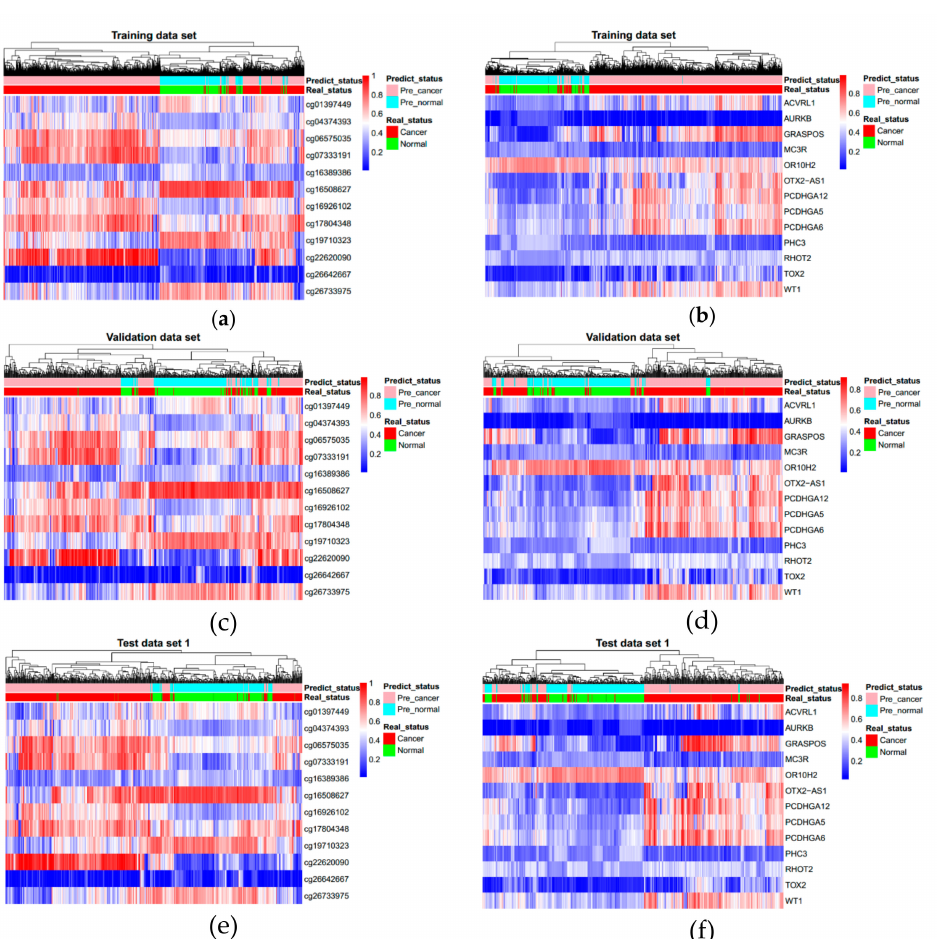
Figure 3. Unsupervised hierarchical clustering of the three data sets. ( a , c , e ) come from 12 CpG markers and ( b , d , f ) come from 13 promoter markers. Methylation beta values range from 0 to 1.